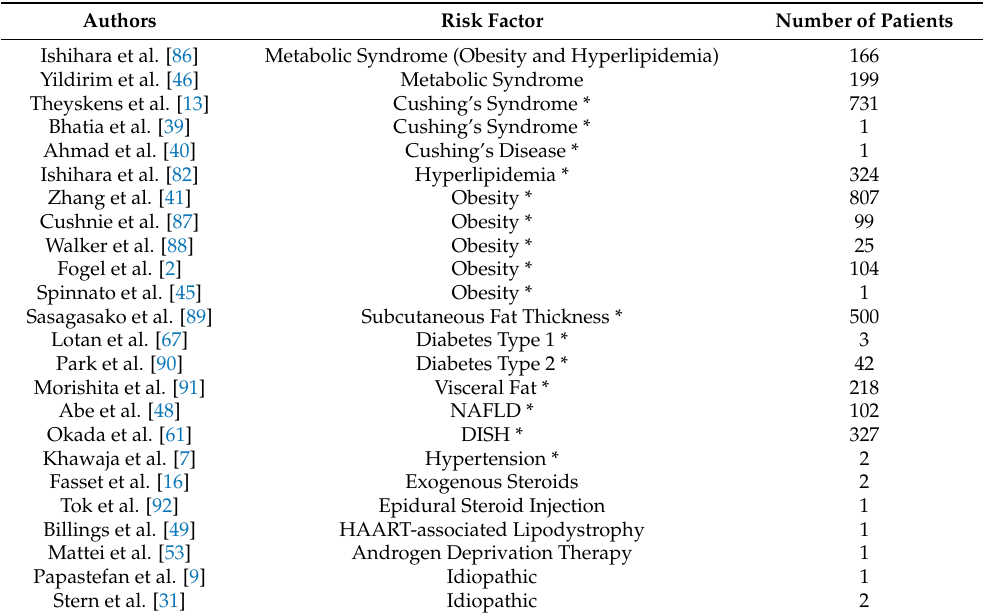
Table 2. List of relevant articles in the literature, sorted by main risk factor attributed to SEL. Asterisks (*) indicate risk factors linked to metabolic